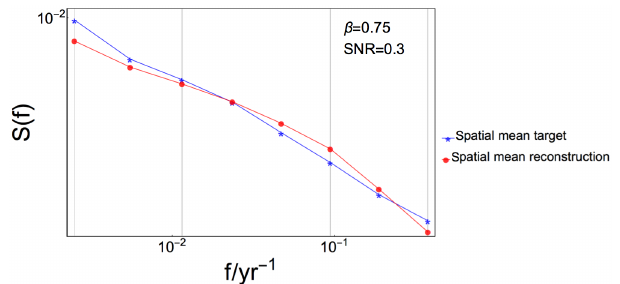
Figure 6. Log–log plot showing log-binned power spectra of spa- tial mean target (blue) and reconstruction (red) for one experiment. Vertical gray lines mark the frequency ranges used to estimate bias of variance as referred to in Sect.